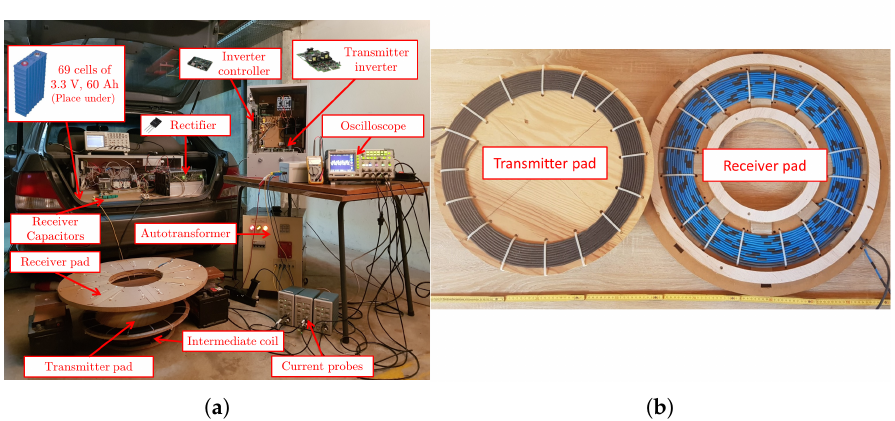
Figure 10. Experimental prototype built in a converted combustion vehicle: ( a ) Main overview and ( b ) transmitter and receiver